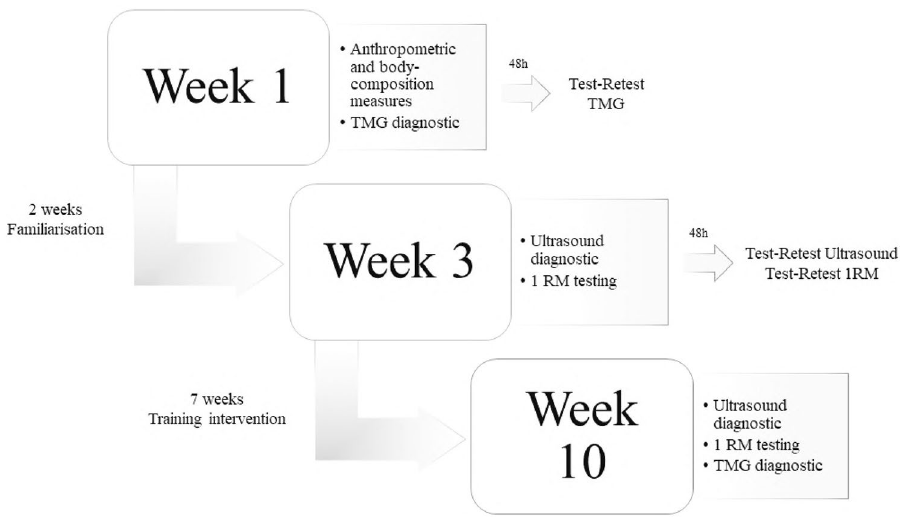
Figure 1. Schematic figure of study design. Graphical representation was designed using Adobe Photoshop software version 23.0.1 (https:// www. adobe. com/ produ cts/ photo shop.